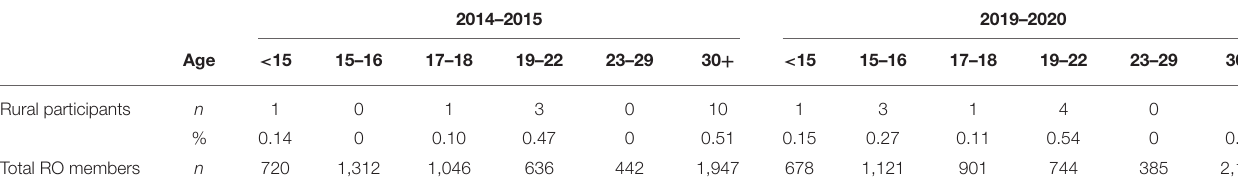
TABLE 2 | Rurality of PSO members by age groups for 2014–2015 and 2019–2020